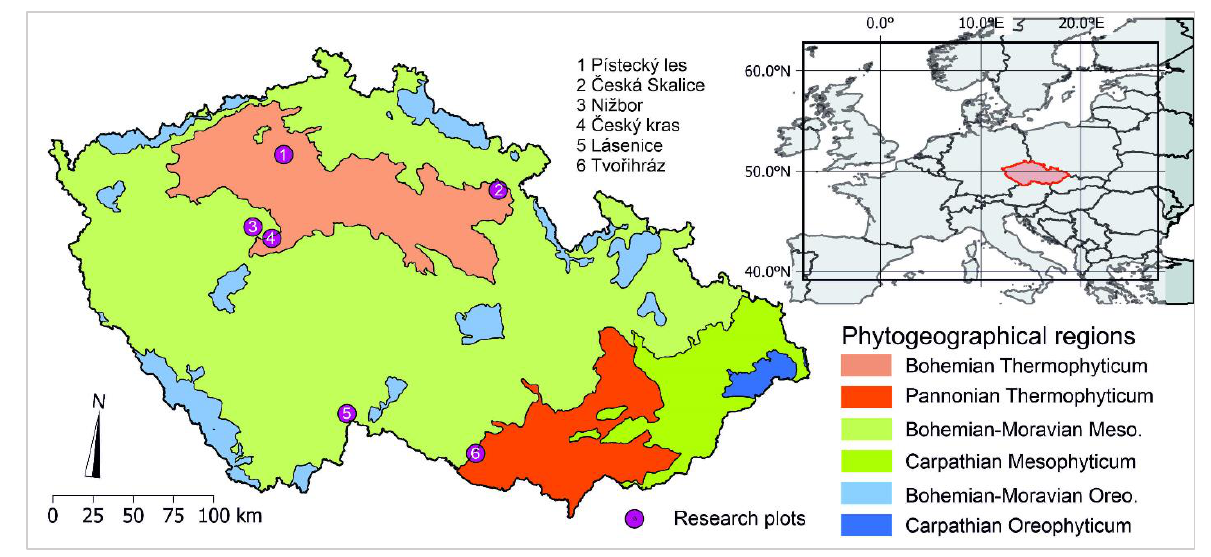
Figure 2. Studied oak plots with declining trees: 1 = Pístecký les, 2 = Česká Skalice, 3 = Nižbor, 4 = Č eský kras, 5 = Lásenice, 6 = Tvořihráz . Table 1. Characteristics of the studied oak plots.